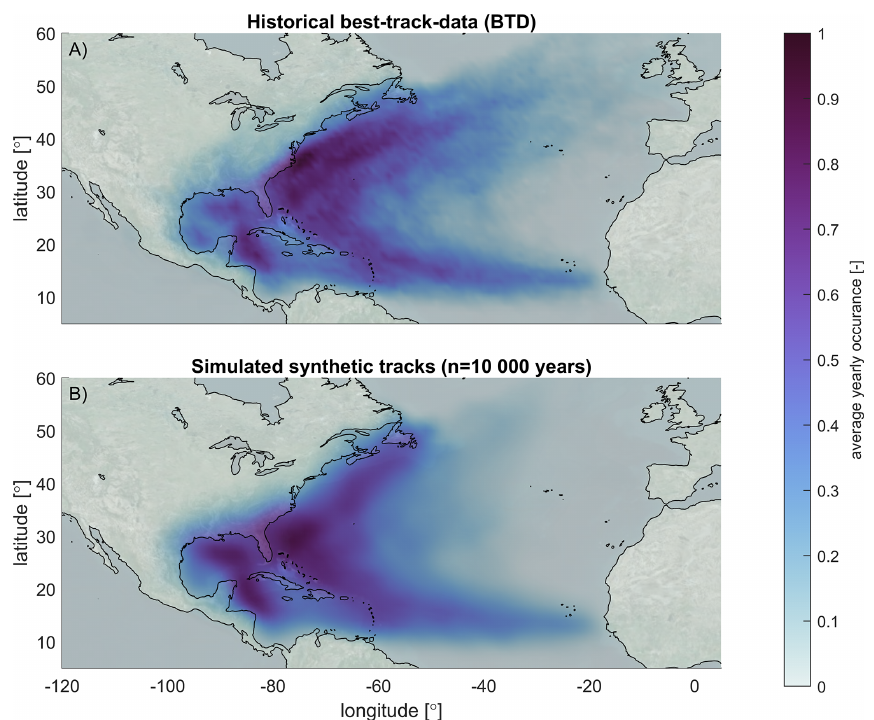
Figure 5. Average occurrence of historical BTD (a) and simulated TCs with TCWiSE (b) for the NA basin. Occurrence is based on TCs within 200km per grid cell for historical TCs from 1886–2019 and 10000 years of simulated events. © Microsoft Bing